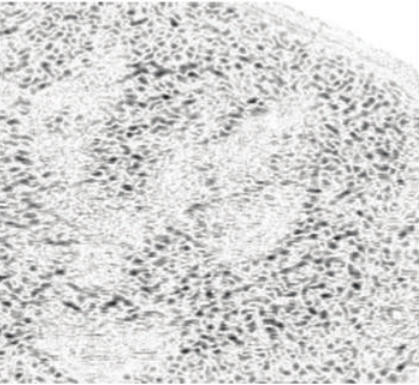
Figure 9: Absolute-valued difference between stage-I and stage-II of our method.